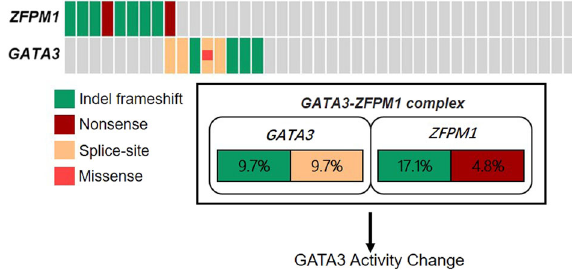
Fig. 6 The mutations of ZFPM1 and GATA3 . Mutual exclusivity analysis between ZFPM1 and GATA3 mutations in EPC. The frequency of alteration in EPCs was shown in the box, p = 0.659, Fisher ’ s exact test. Each column denotes an individual tumor, and each row represents a mutation. The different colors represented different mutation